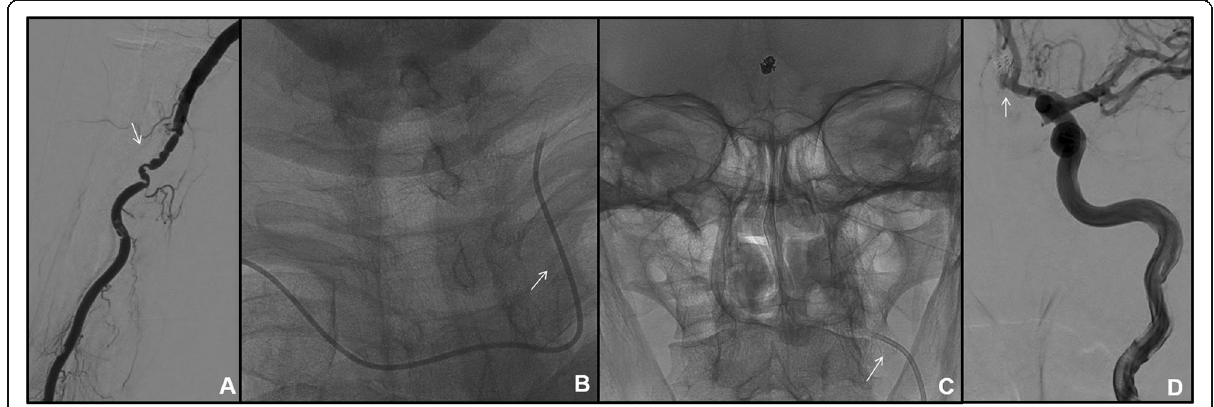
Fig. 2 Follow-up cerebral DSA for ACoA aneurysm treated with simple coiling. Small right radial lumen and vasospasm (arrow in a ) required a 4-F introducer kit; a 4-F SIM 1 catheter was advanced through the aortic arch into the left ICA (arrow in b and c ); selective left ICA